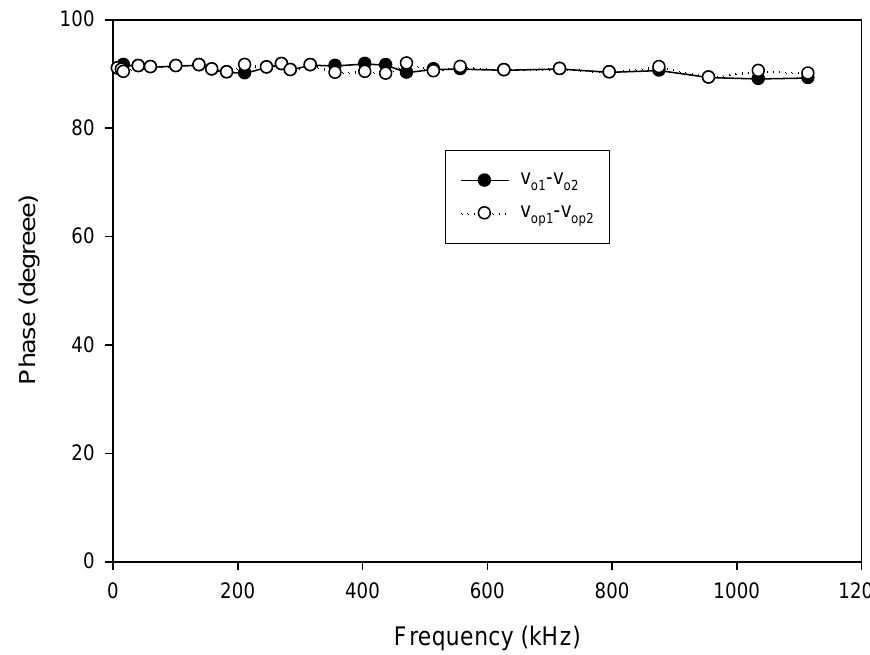
ff erence of the quadrature output Figure 13. Phase difference of the quadrature output voltage. Figure 13. Phase di